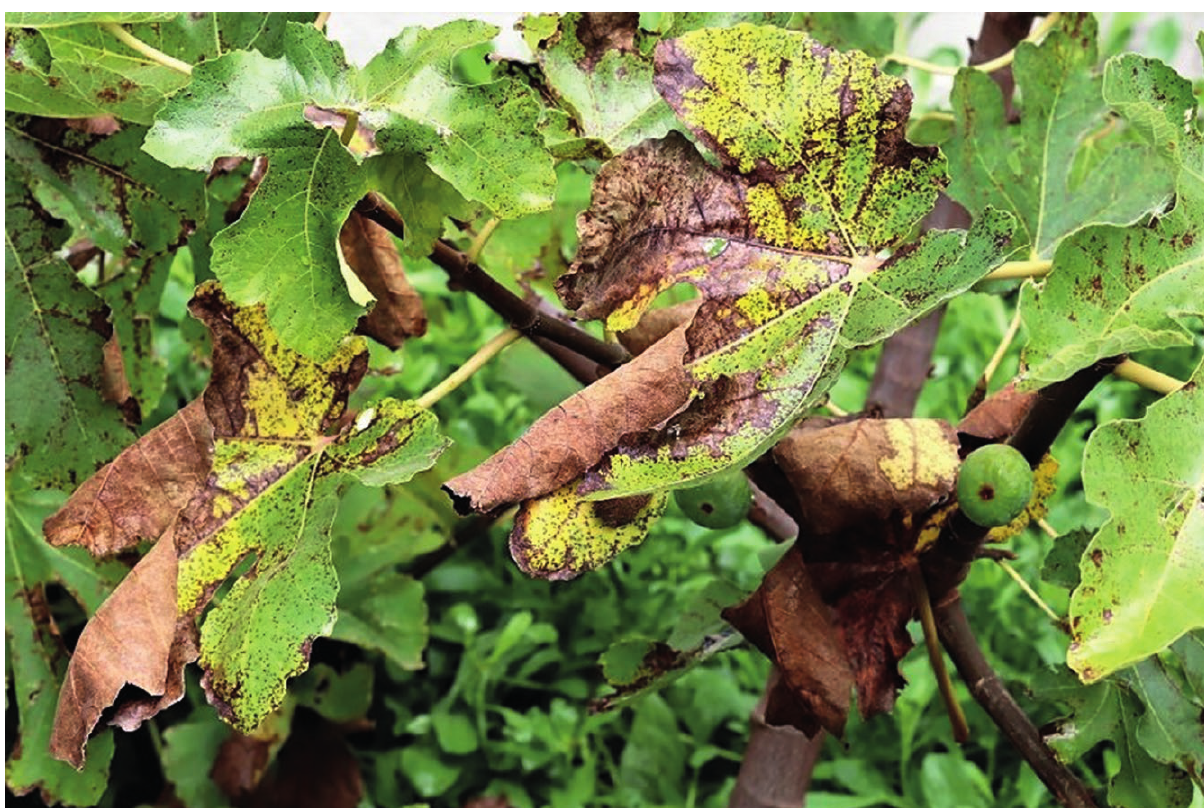
Figure 1. Rust damage on leaves of a fig tree in a residential garden in Vermont, Western Cape, South Africa, in February